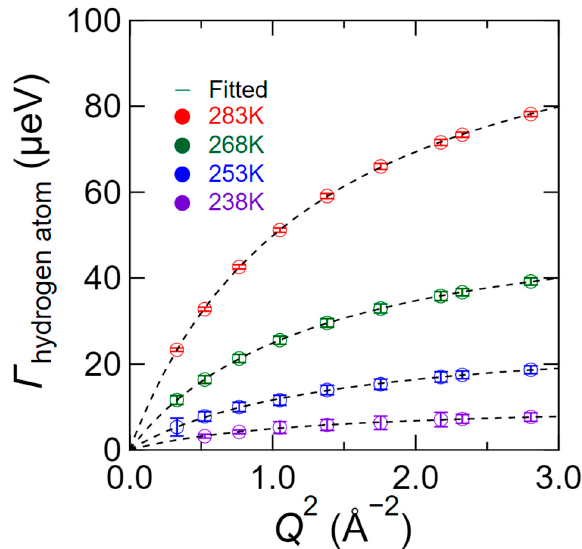
Figure 12. The Q 2 -dependence of Γ hydrogen atom at 238 K (purple), 253 K (blue), 268 K (green), and 283 K (red) for S D ( Q , ω ), as obtained by profile fitting to Equation (2). The broken curves on Γ hydrogen atom plot represent the fitted results obtained by the jump-diffusion model [30].